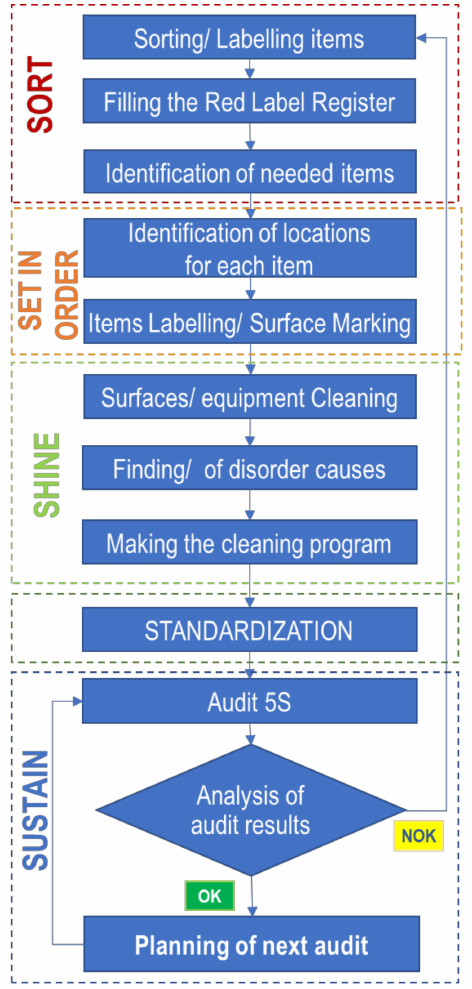
Figure 10. 5S application